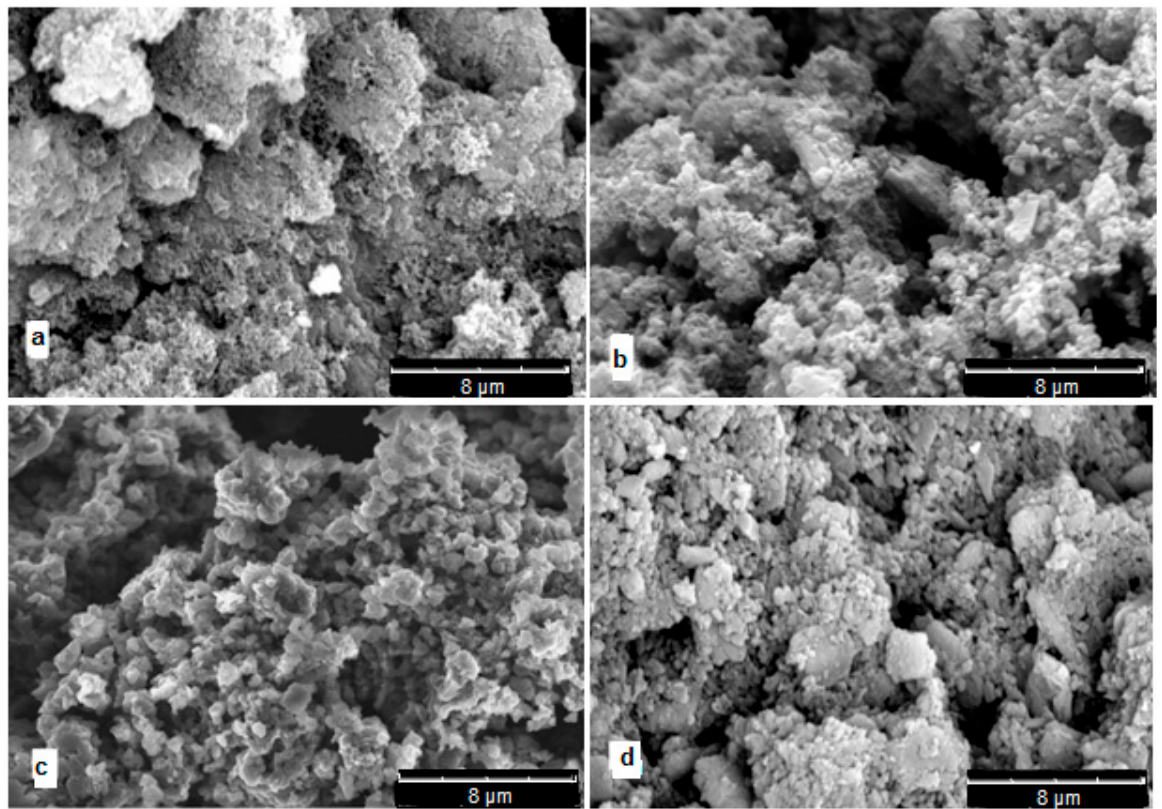
Figure 13. SEM micrographs: ( a )—PANI, ( b )—poly-DADCB, ( c )—poly-DPDCB, ( d )—poly-ASADCB.